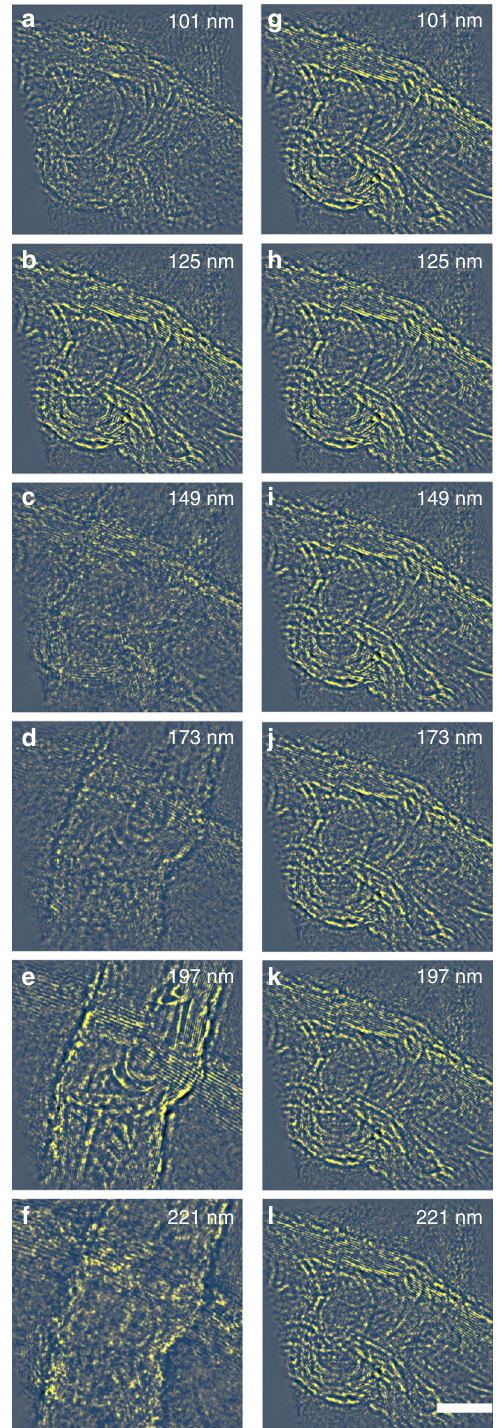
Fig. 2 Comparison between reconstruction and propagation effects. a – f Reconstructed phases at six positions along the optical axis within the sample. b and e show slices where the upper and lower CNTs are at the Gaussian focus, respectively. Pixel size = 17 pm; image size = 2400 × 2400 pixels. g – l Fresnel propagation of the reconstructed complex object image phase in b to the appropriate sample height. The invMS method shows a depth sensitivity different from that due to simple Fresnel propagation of the reconstructed exit wave function. For example, the lower CNT, becomes visible using invMS optical sectioning in e , but remains invisible after applying Fresnel propagation in k . The depth value at the top-right corner in each fi gure is de fi ned as the distance from the probe focal point. The 10 nm scale bar is the same for all fi